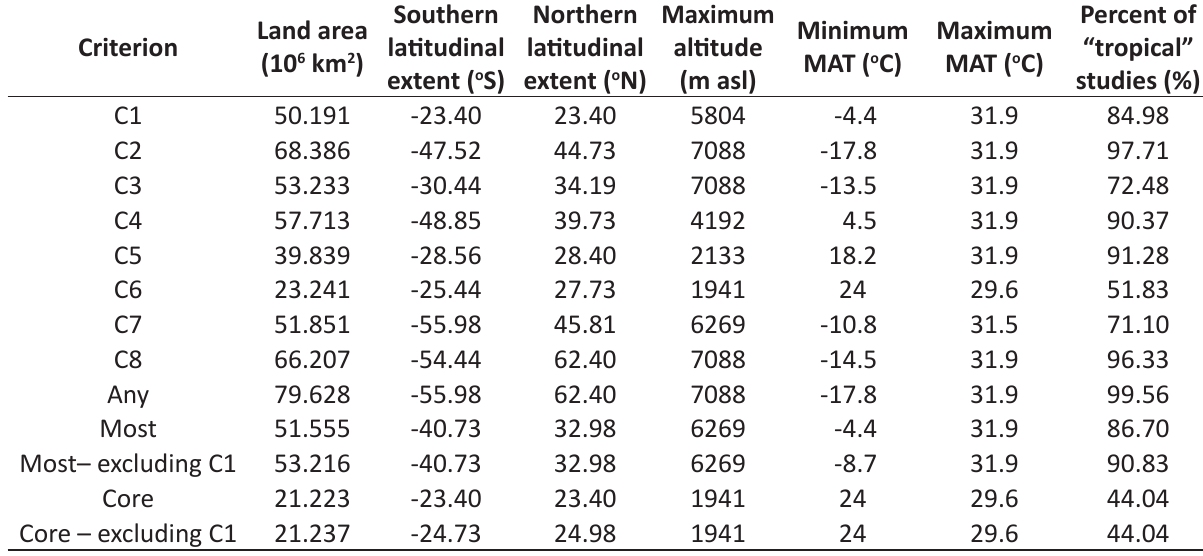
Table 2. The extent and climate of land areas defined as being tropical under different criteria. See Table 1 for descriptions of each criterion, Figure 1 for maps of tropical land areas under each criterion, and Supplemental Online Table 1 for citations and classification of tropical